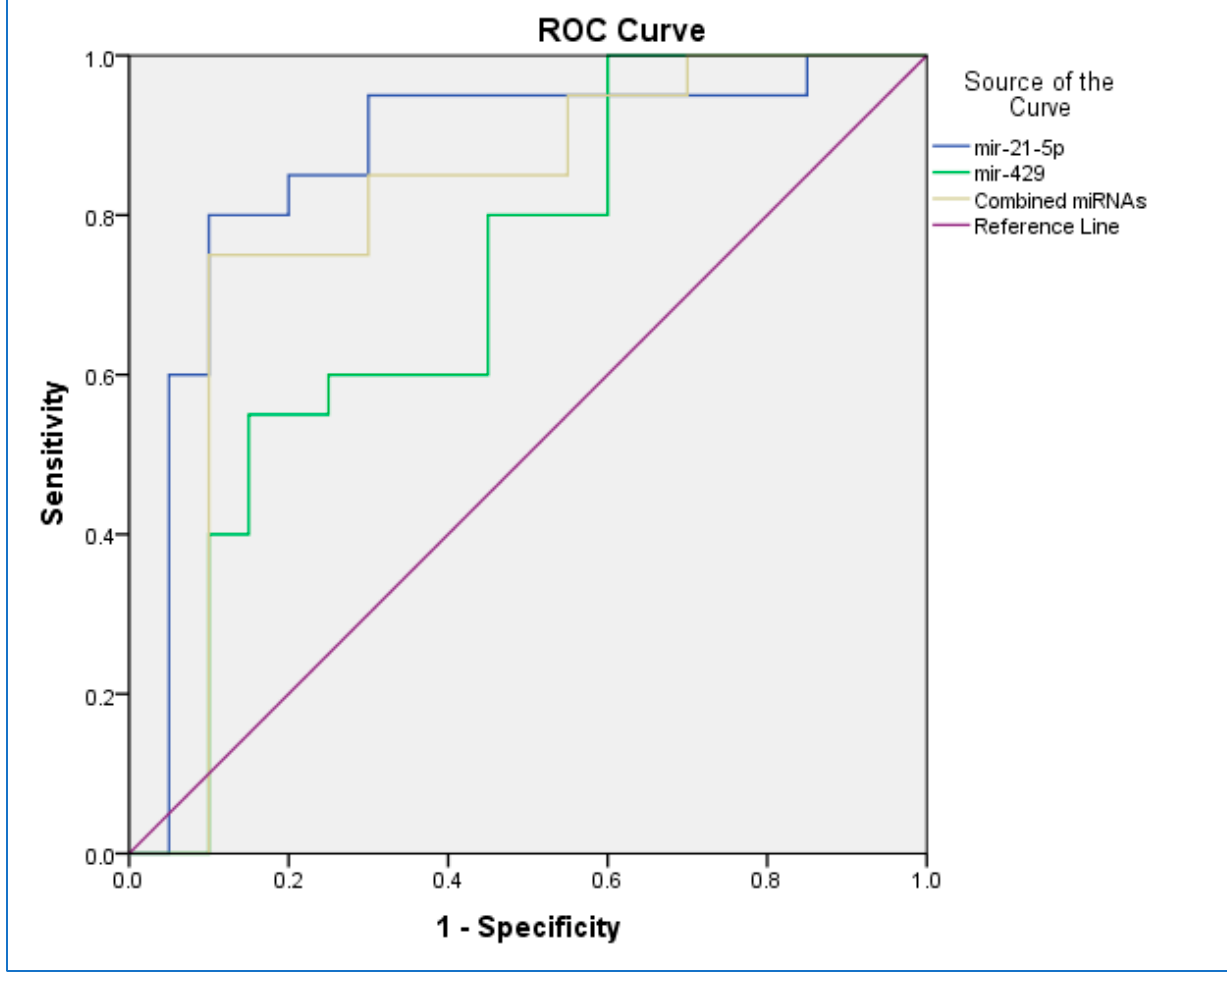
Figure 2. The receiver operating characteristic (ROC) curve for miR-21-5p and miR-429 and combined miRNAs.